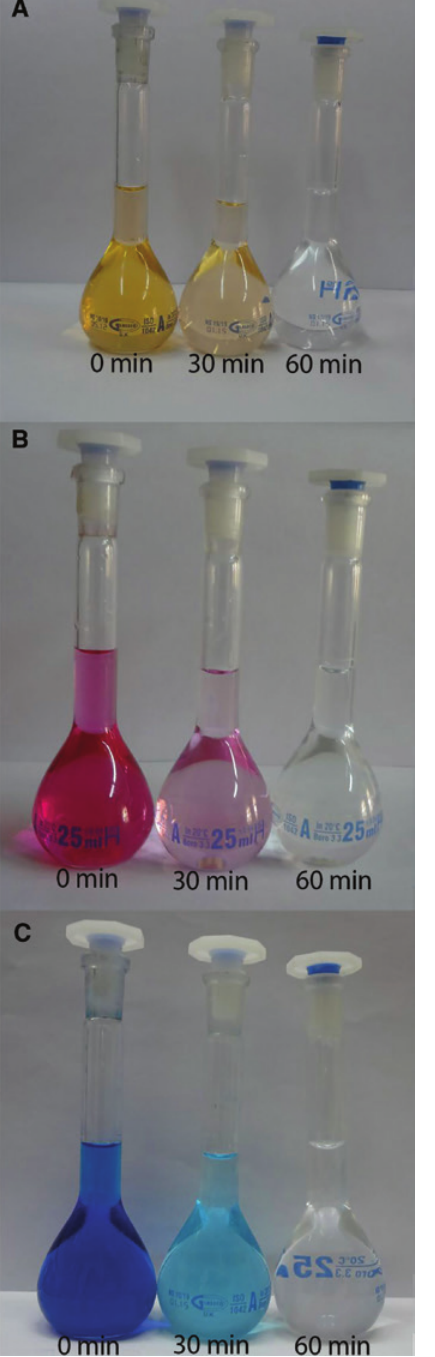
Figure 8: Photodegradation of azo-dyes under UV-Vis: (A) acid brown; (B) acid violet; and (C) acid